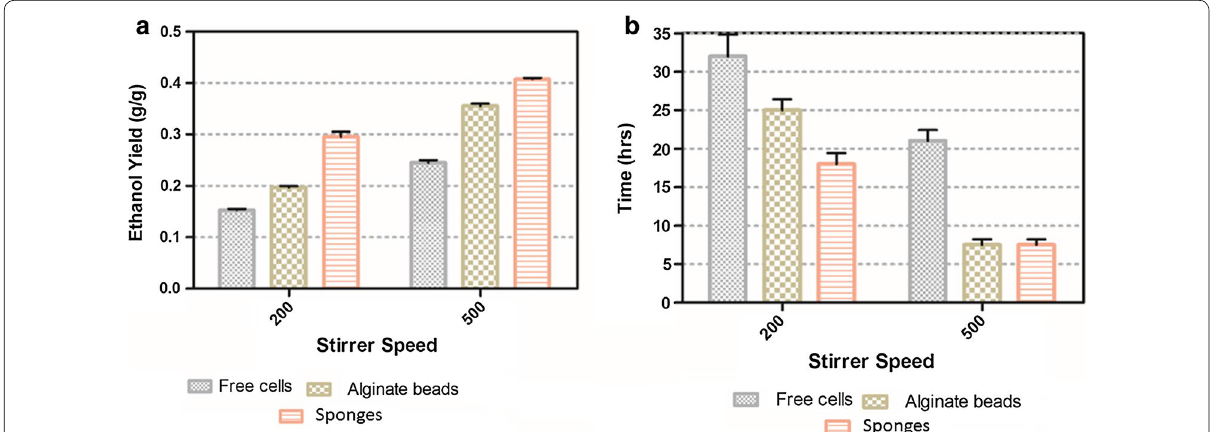
Fig. 5 Ethanol yield and glucose consumption time by free and immobilized cells in alginate beads and sponges. a Ethanol yield, b Glucose con‑ sumption